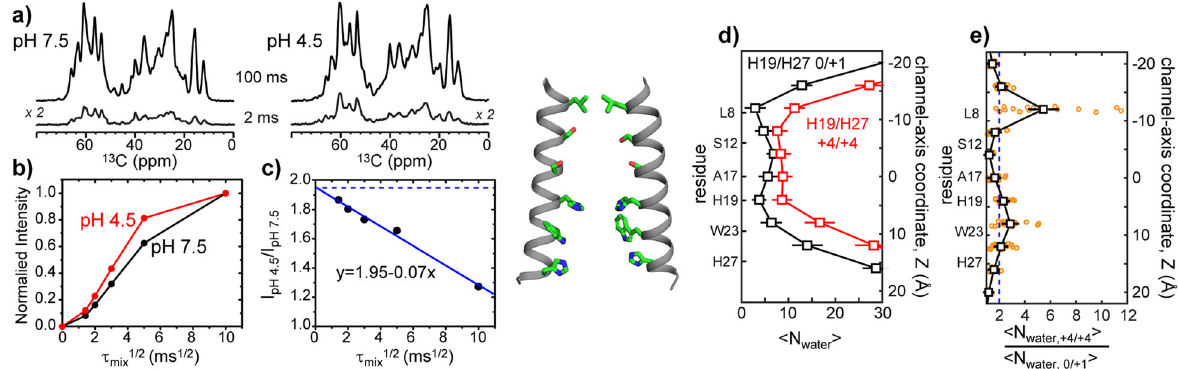
Fig. 2 Experimental and simulated water amounts in closed and open BM2 channels. a Water-transferred 13 C spectra with 2 ms and 100 ms 1 H mixing times at pH 7.5 and pH 4.5. Note the higher intensities of the 2-ms spectrum of the low-pH sample compared to the high-pH sample. b Normalized water- transferred intensity (S/S 0 ) as a function of mixing time τ mix . The protein shows faster intensity buildup at low pH than at high pH. c Ratio of the low-pH versus high-pH water-transferred intensities as a function of 1 H mixing time. The ratio has an intercept of 1.95 (blue dashed line), indicating that the low-pH channel contains at least 1.95-fold more water than the high-pH channel. d Simulated average number of water molecules in 4 Å bins along the channel axis in the open (red) and closed (black) states. A ribbon view of the BM2 TM domain is shown on the left to illustrate the positions of key residues (sticks). For clarity, only two out of four TM helices are shown. e Ratio of the simulated number of water molecules for the open and closed states in 4 Å bins along the channel axis. On average, 2.0 times more water molecules are found in the open channel (blue dashed line), consistent with the experimental data. Black squares and error bars for simulations correspond to the mean and standard error of the mean for four independent trajectories. The data from the individual trajectories are shown as open orange